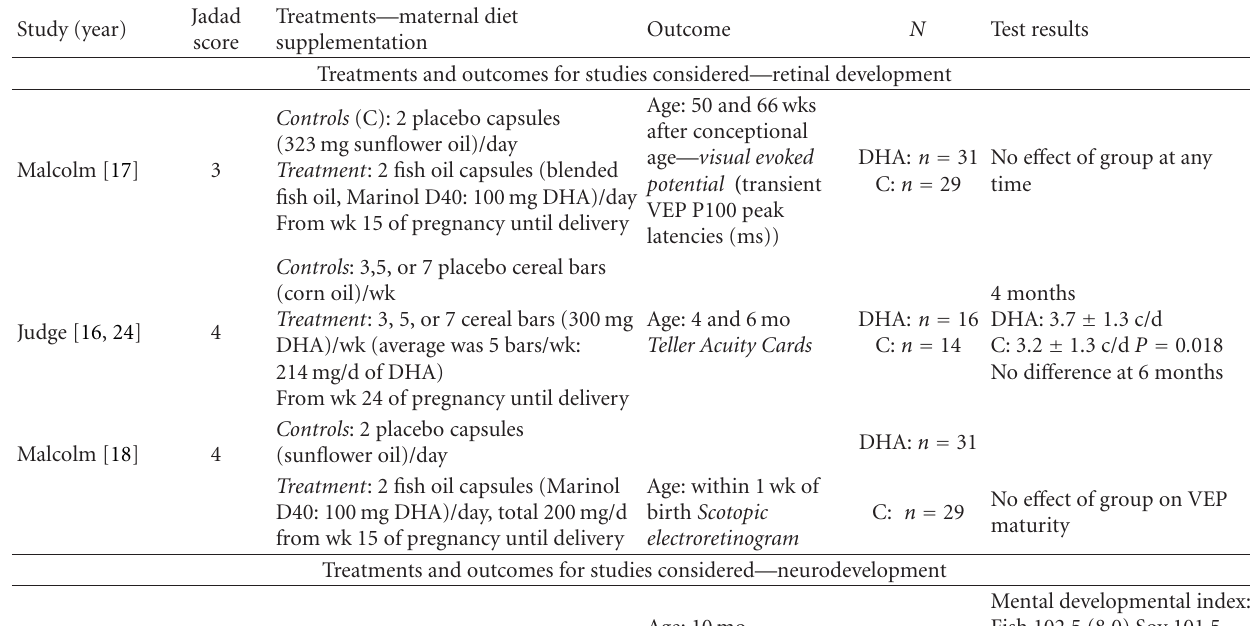
Table 1: Description of included